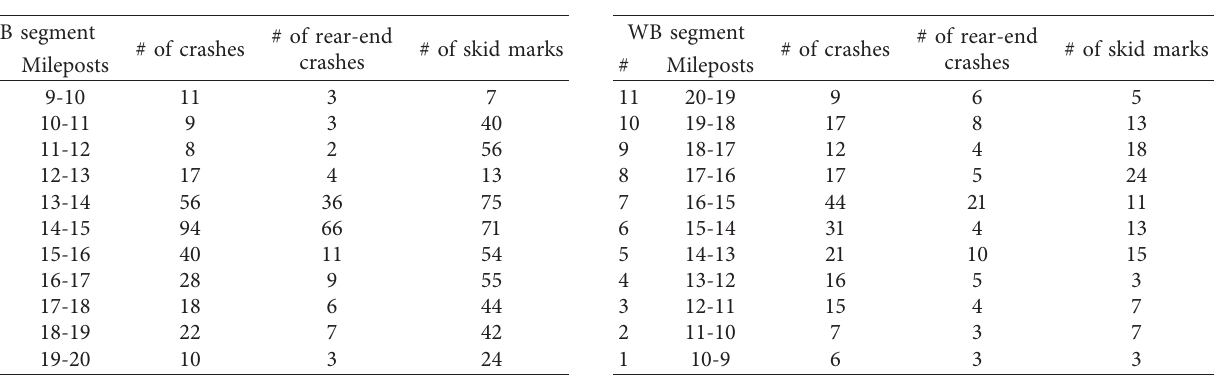
Table 2: Segment crashes and skid marks on Interstate 80 eastbound.